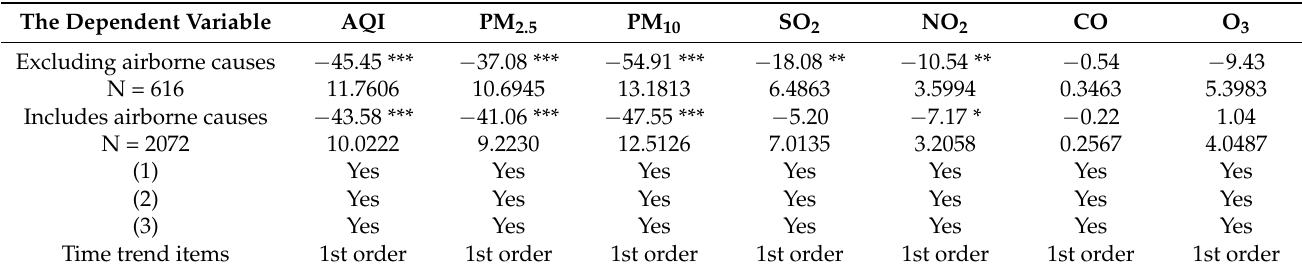
Table 5. Results of RD estimation of the daily frequency of interviewing cities with air problems versus interviewing cities without air problems.